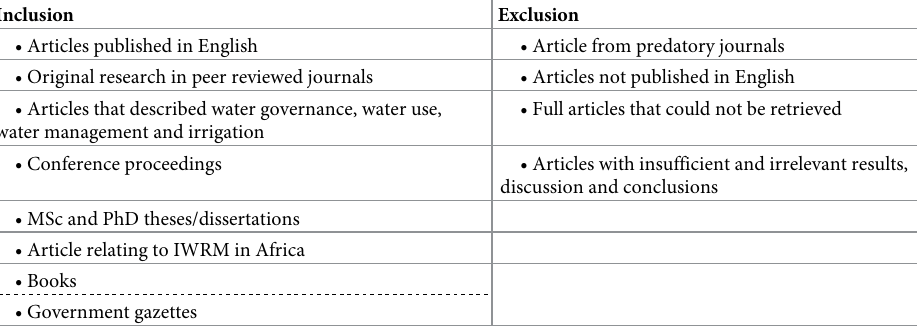
Table 3. Inclusion-Exclusion